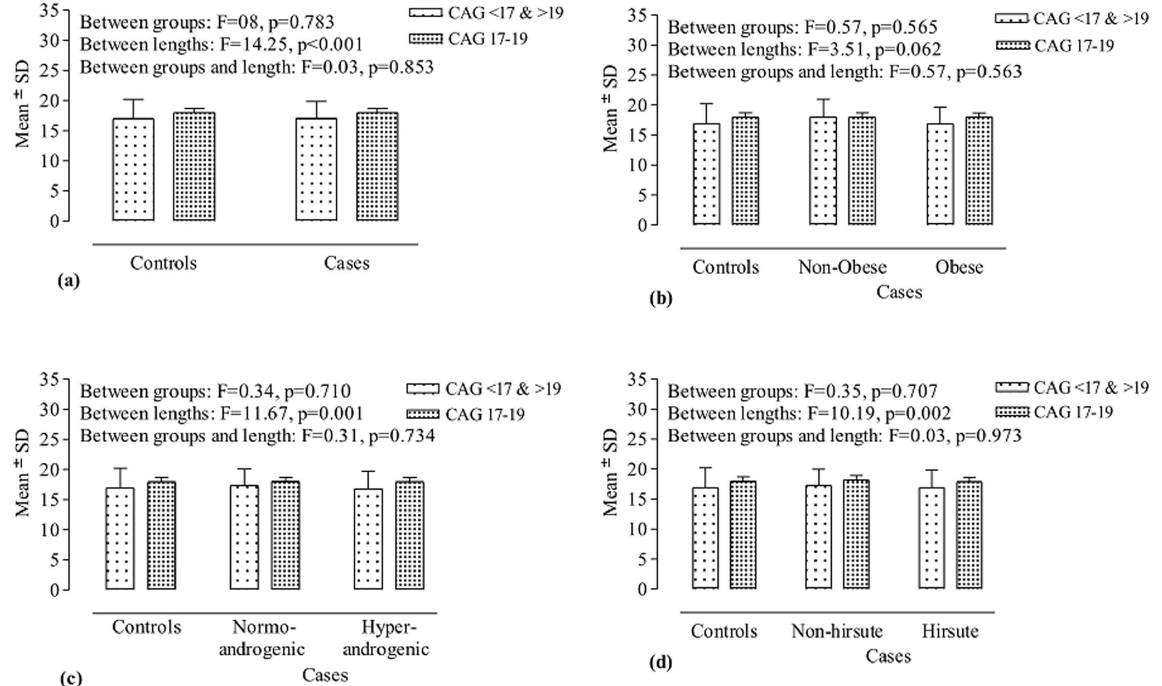
Figure 3. CAG bi-allelic mean distribution. Comparison of bi-allelic mean data in two CAG categories (extreme and moderate alleles) between controls and cases (a), and between controls and case subgroups based on obesity (b), androgenism (c), and hirsutism (d).